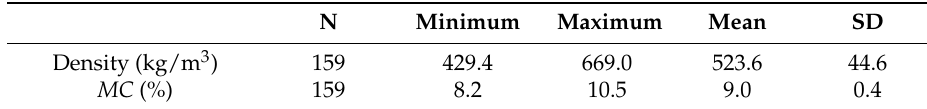
Table 2. Average MC and basic density